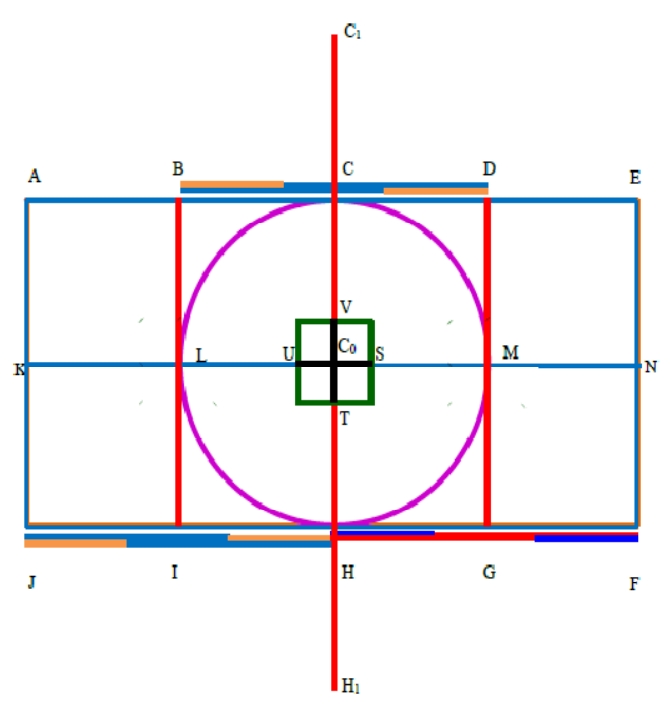
Figure 2. Golden section of